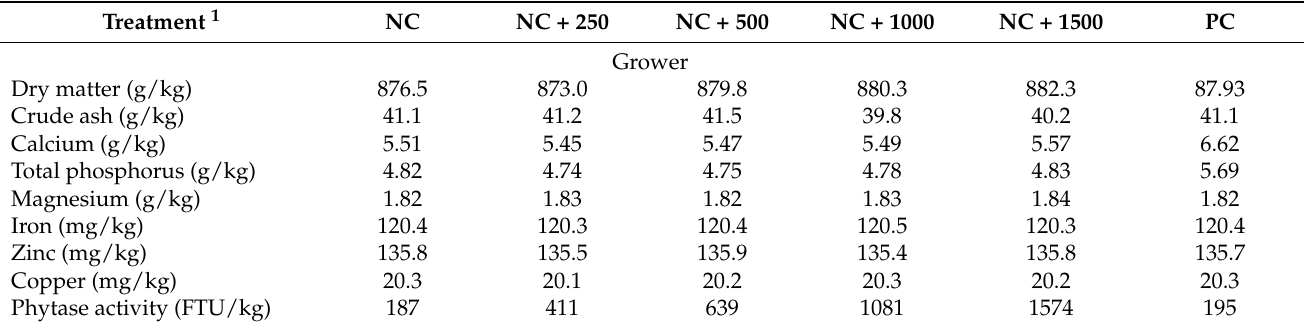
Table 1. Dry matter and crude ash content, mineral concentrations, and total phytase activity (FTU/kg) in grower and finisher pig diets